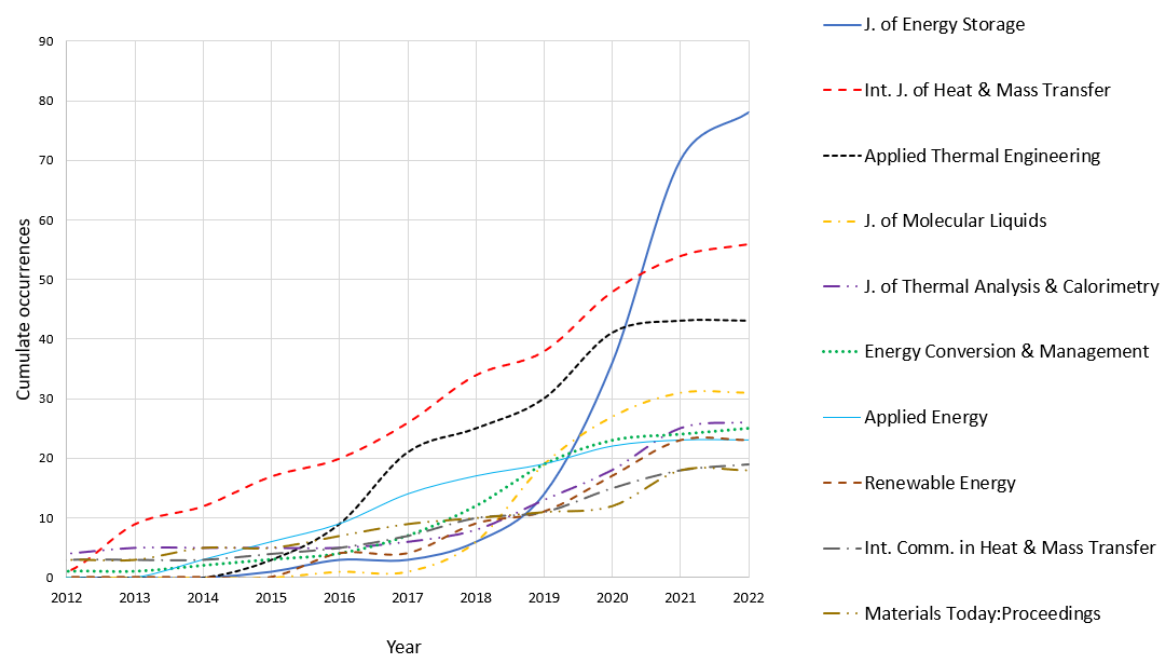
Figure 9. Cumulative evolution of sources in the last 10 years.